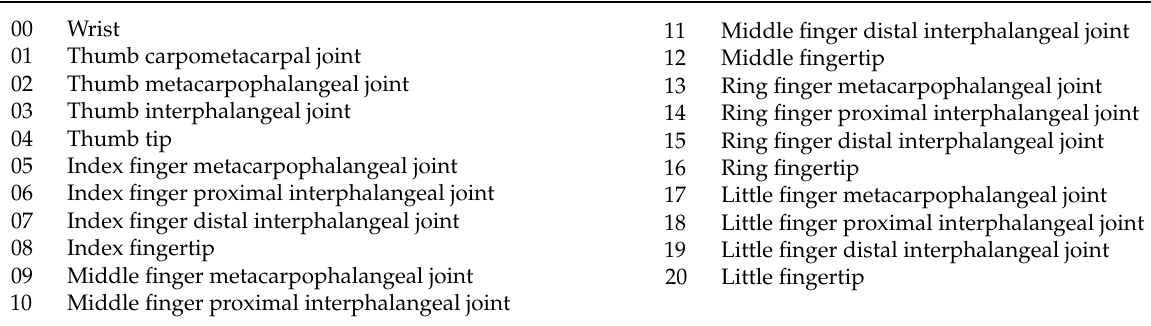
Figure 1. MediaPipe hand landmarks.